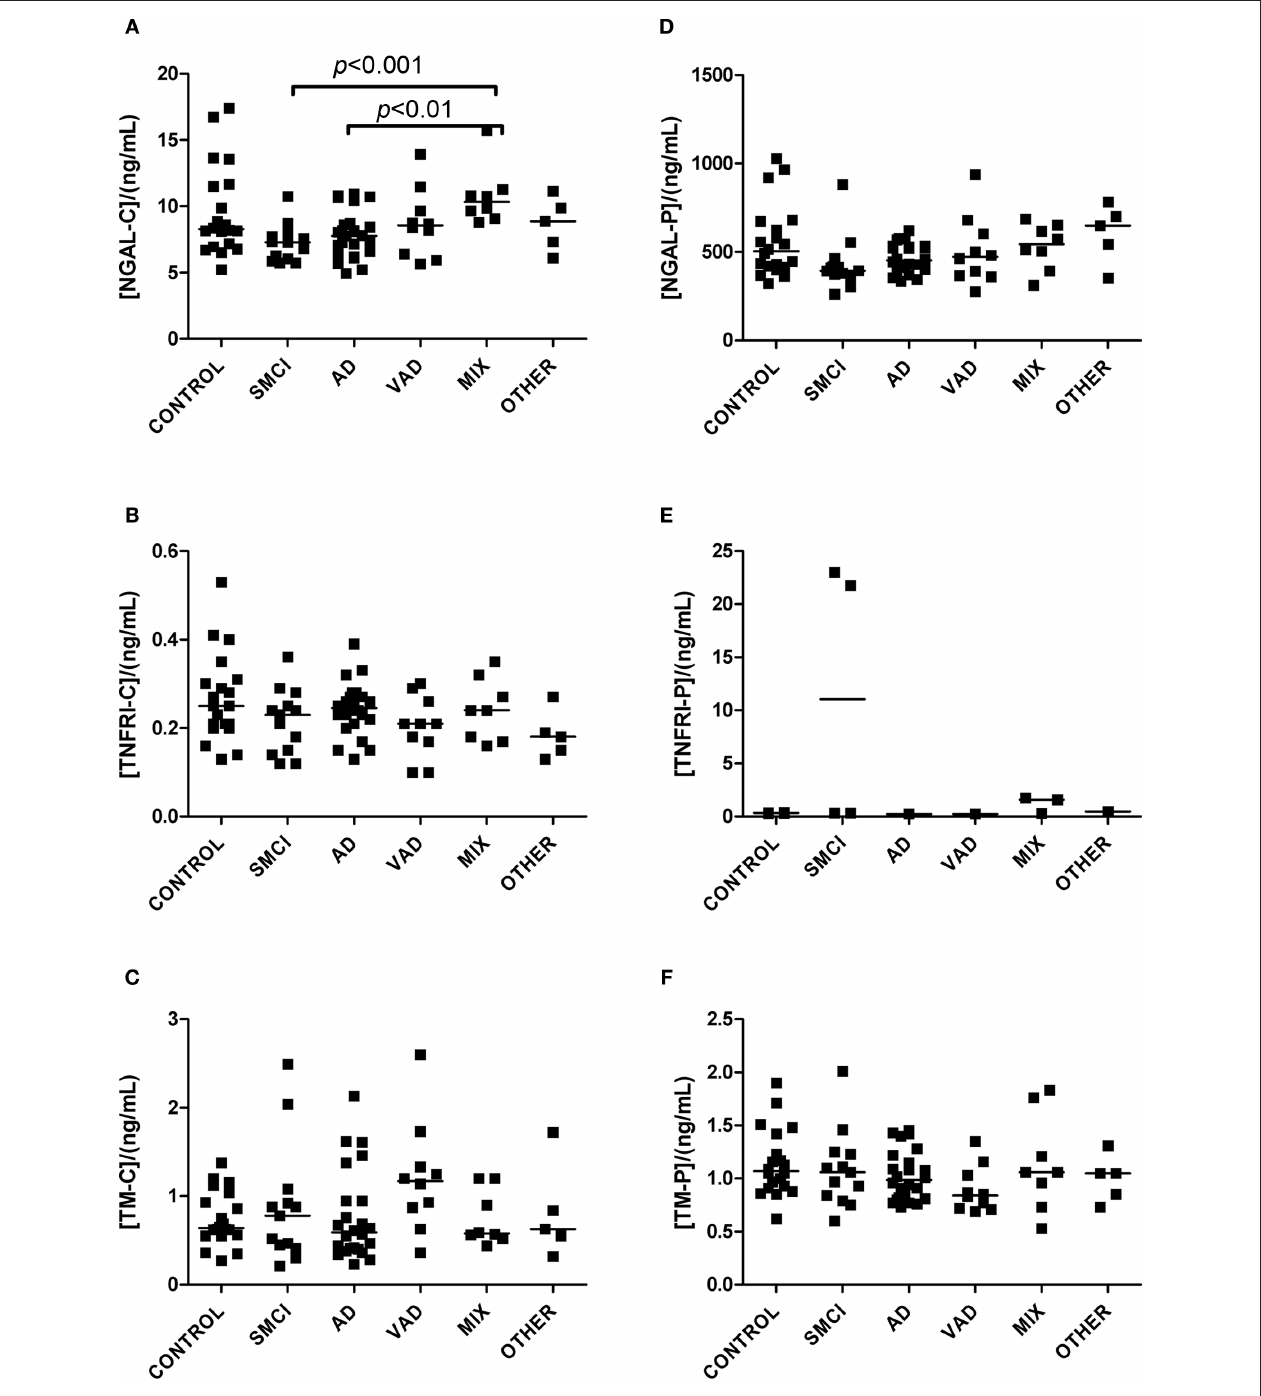
FIguRE 3 | Levels of analytes in plasma and CSF. (A–C) Show values obtained in CSF, and (D–F) display values obtained in plasma. Significant differences between diagnostic groups are shown by brackets. Straight lines indicate median values.